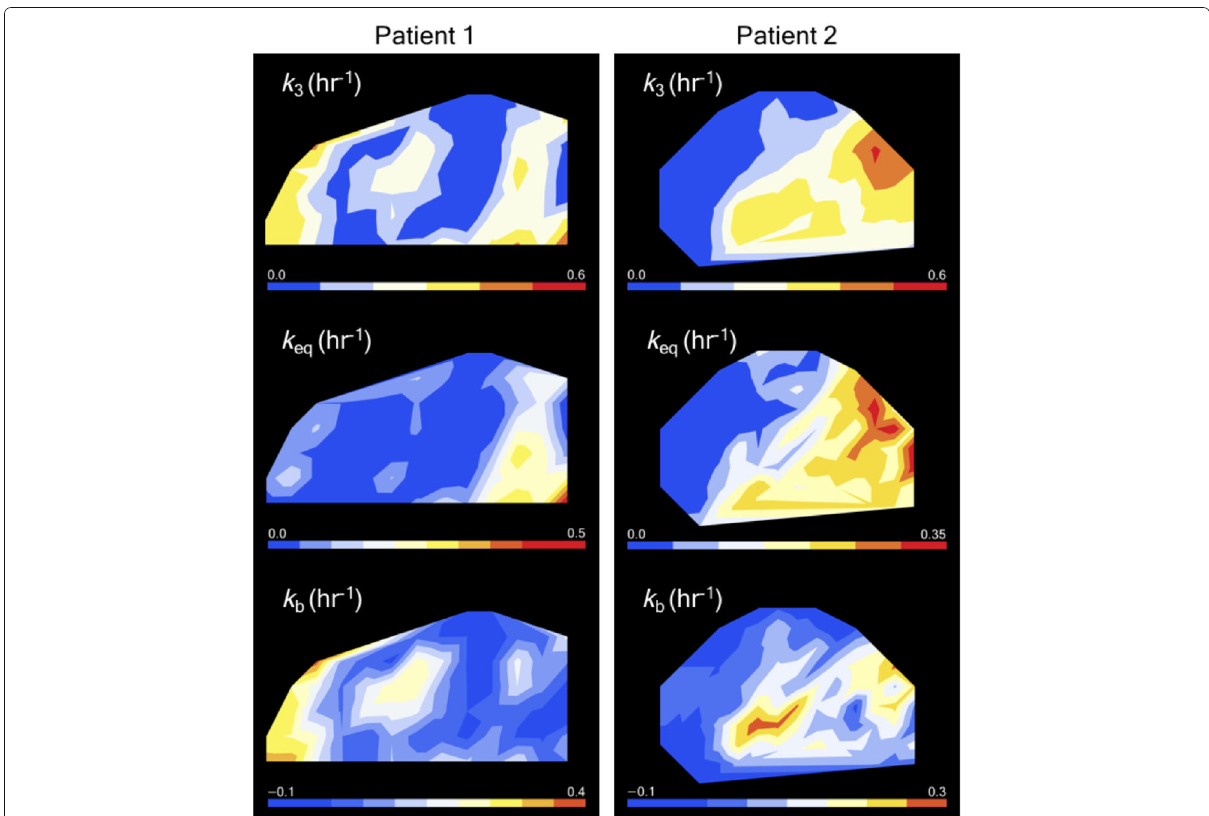
Fig. 5 Parametric maps for an axial tumour slice from patients 1 (left) and 2 (right) showing the spatial distribution of binding and equilibration rates